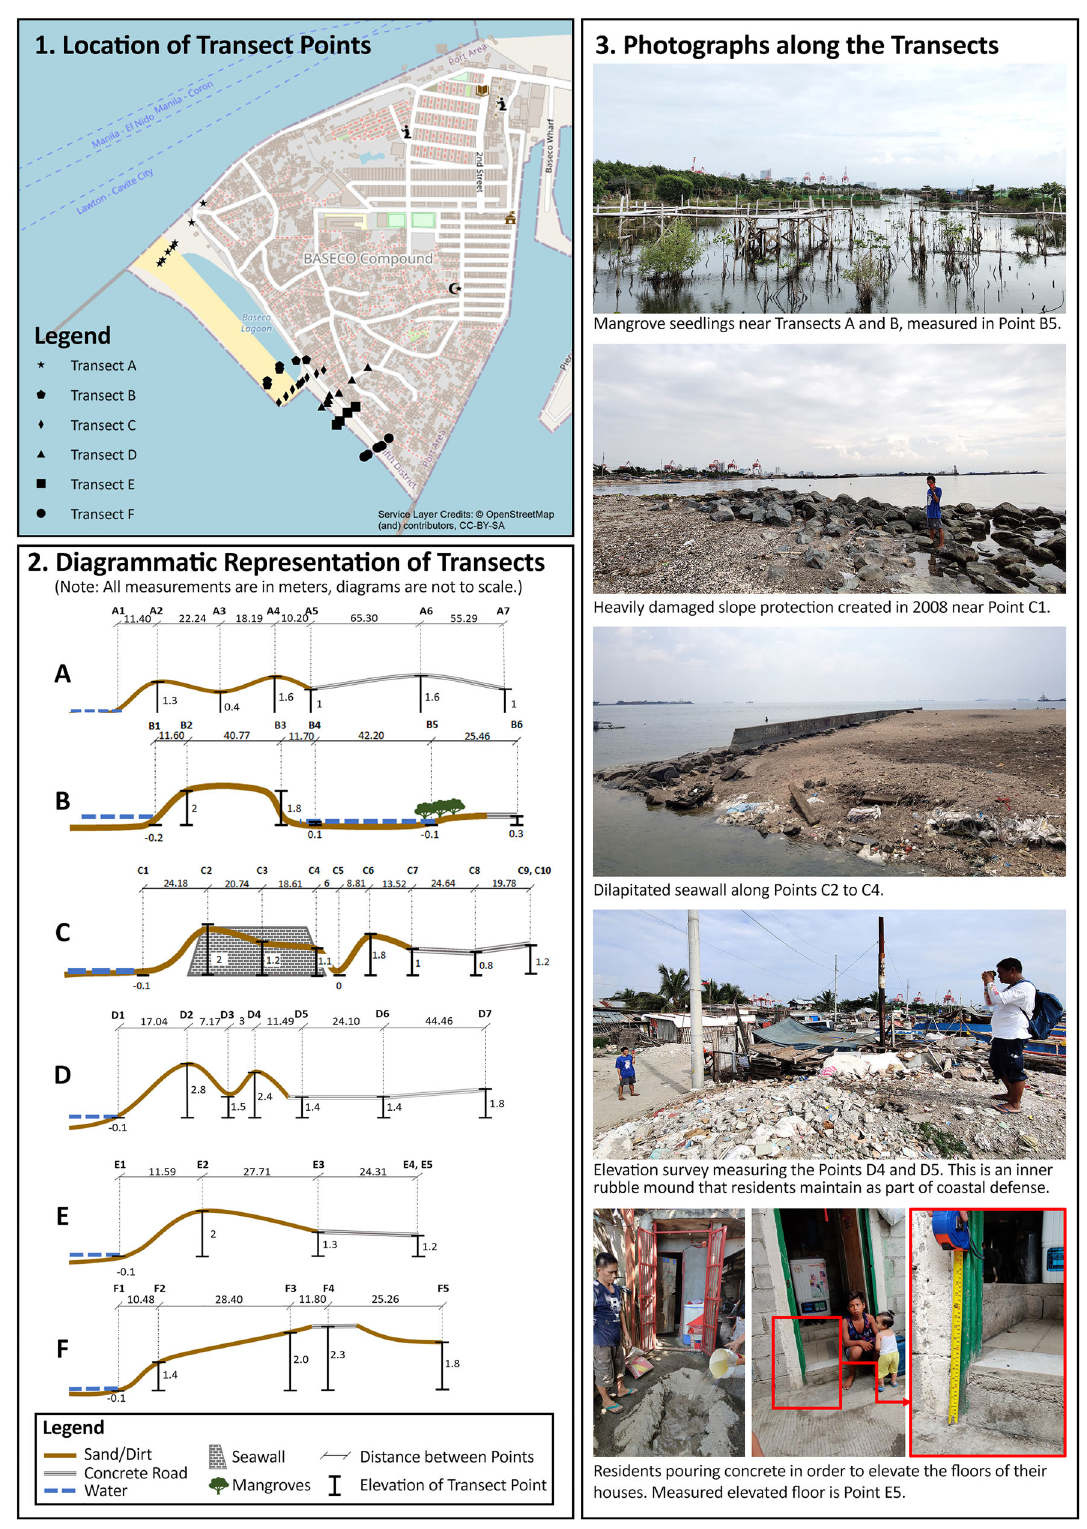
Fig. 3 Summary of topographic survey, transect points, and photographs of BASECO Compound in Manila. Photographs taken by Ven Paolo B. Valenzuela, 20 November